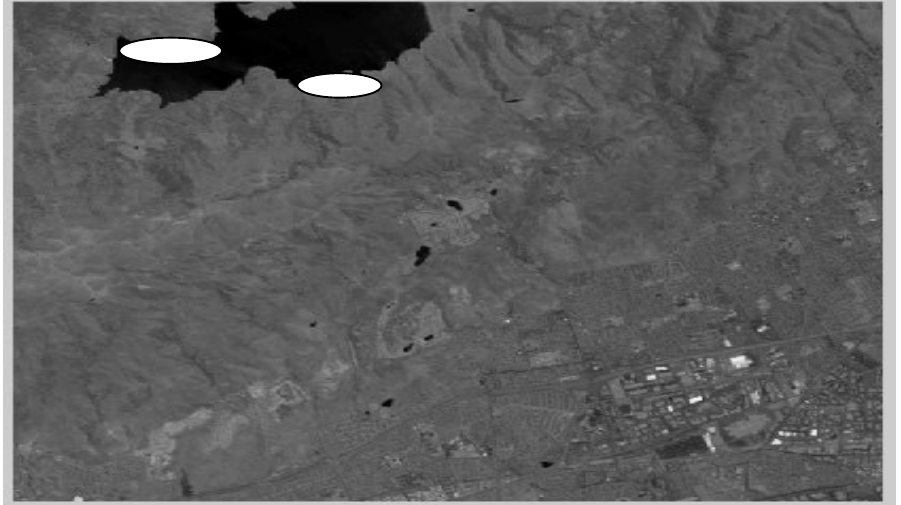
Figure 1 . Scene A. Typical broadband image of a scene that is cluttered because it includes mountains, buildings, and water, but contains no plumes. Similar images are available from the Jet Propulsion Lab’s AVIRIS website [1]. The two white ovals are hypothetical results of a plume- detection method, indicating either false alarms or the presence of gaseous plumes along the lake